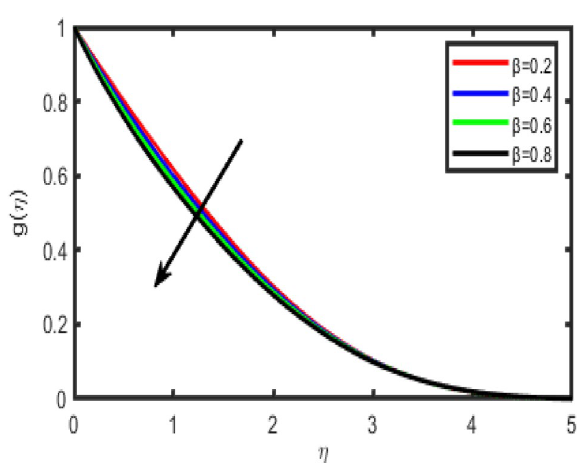
Figure 11. Effect of Casson fluid parameter (β) on transverse velocity g(η).